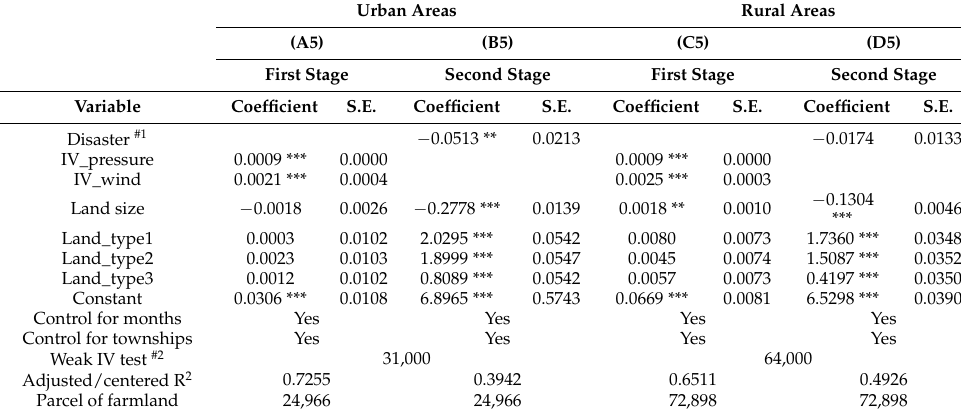
Table 5. Estimation results of the incidence of receiving agricultural disaster payments on farmland prices by regions (IV-FE